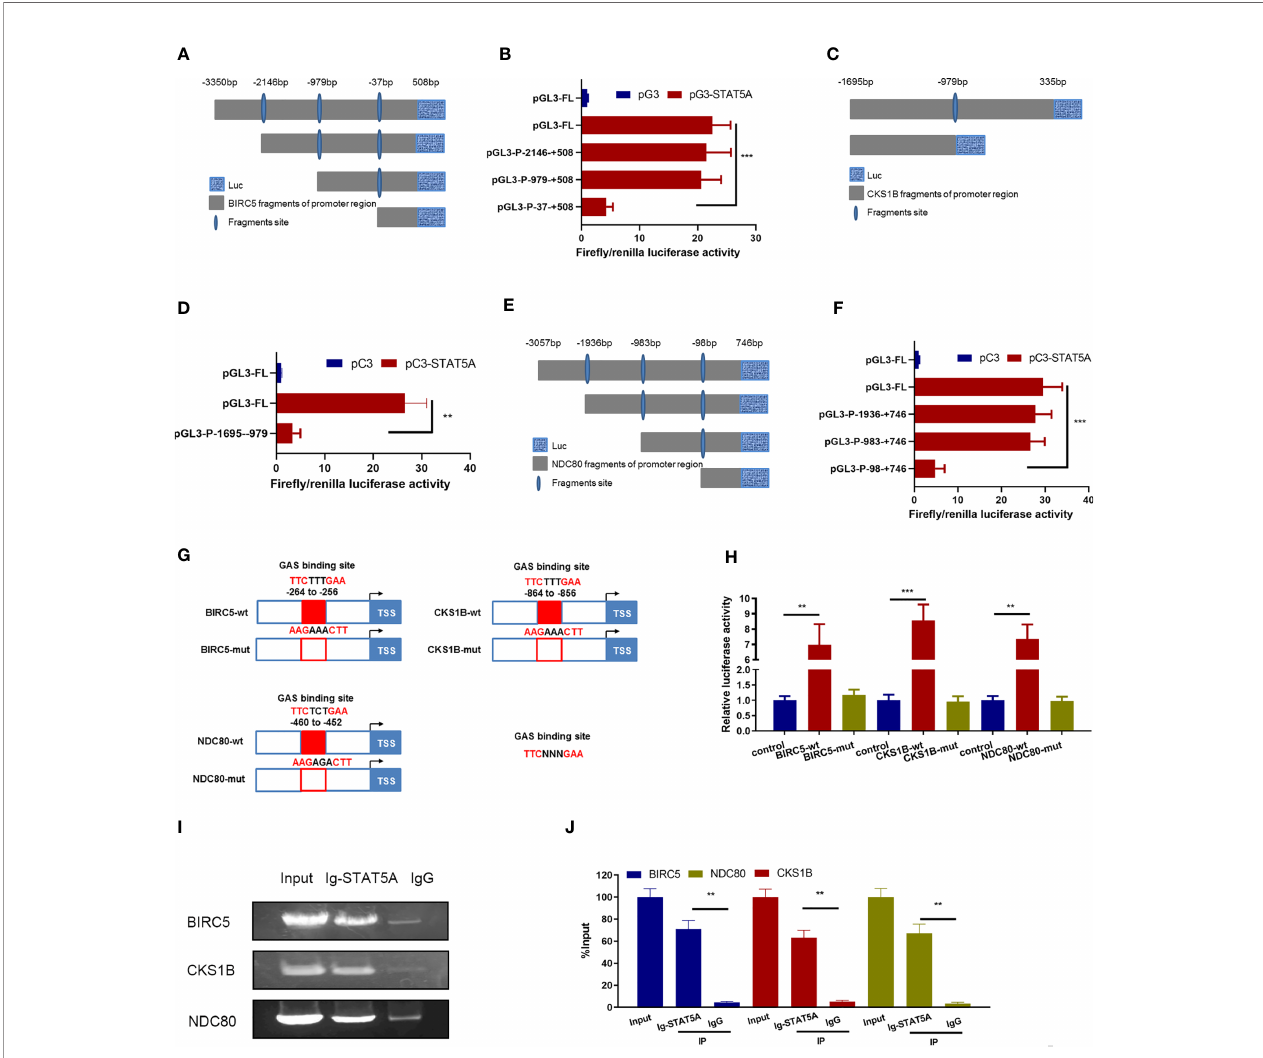
FIGURE 5 | STAT5A directly bound to BIRC5 , CKS1B , and NDC80 promoters via GAS sites. (A) Schematic diagram of BIRC5 promoter reporter plasmids. (B) HUVECs received the indicated treatments including pC3, pC3-STAT5A plasmids, and TSA for 48 (h) HUVECs were subjected to luciferase assays. (C) Schematic truncations of CKS1B promoter reporter plasmids. (D) HUVECs received the indicated treatments including pC3, pC3-STAT5A plasmids, and TSA for 48 (h) HUVECs were subjected to luciferase assays. (E) Schematic truncations of NDC80 promoter reporter plasmids. (F) HUVECs were treated with TSA and NDC80 promoter truncations, pC3, or pC3-STAT5A and subjected to luciferase assays. (G) Schematic illustration of wild type and mutants for STAT5A binding to BIRC5 , CKS1B , and NDC80 promoter. (H) HUVECs were transfected with different plasmids for 48 h and subjected to luciferase reporter assay. (I, J) ChIP assay with an anti-STAT5A or IgG antibody was performed to detect the interaction of STAT5A and BIRC5 , CKS1B , and NDC80 promoter. Graph of agarose gel electrophoresis for the indicated PCR products (I) . (J) Enrichment of promoter regions for STAT5A was tested b y qRT-PCR. FL, full length. ** P < 0.01, *** P < 0.001 vs. the control